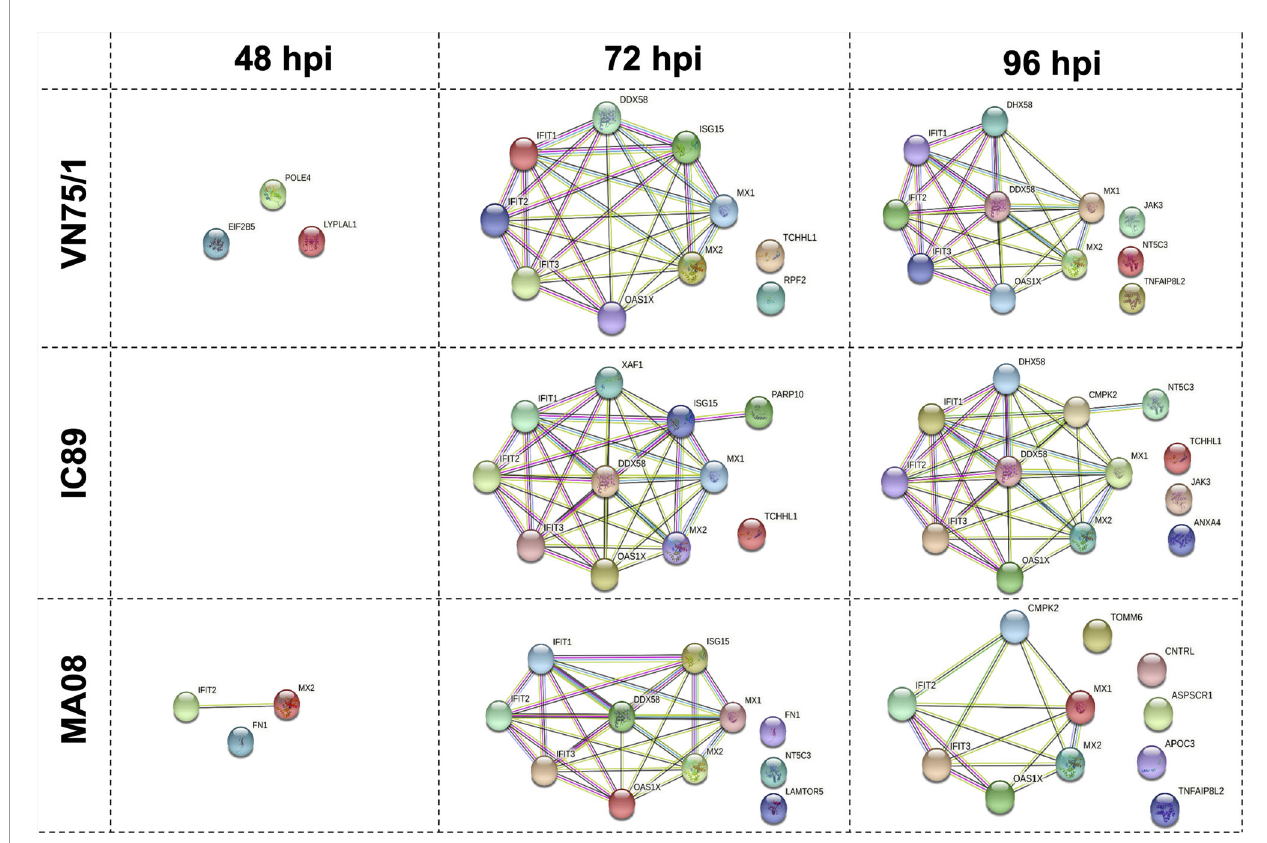
FIGURE 6 | Protein-protein networks generated during PPRV infections of PBMCs. Data at 48, 72 and 96 hpi were obtained by comparing each infection (VN751, IC89, MA08) to the control (Mock infected cells). Each protein is represented by a different colour circle, picked randomly by the software. The colour of a same protein may differ between each analysis. The colours of the lines between the proteins determine the level of interactions. Known interactions are represented by pink (experimentally determined) and blue (from curated databases) lines. Green (text mining), black (co-expression) and grey (protein homology) lines represent other